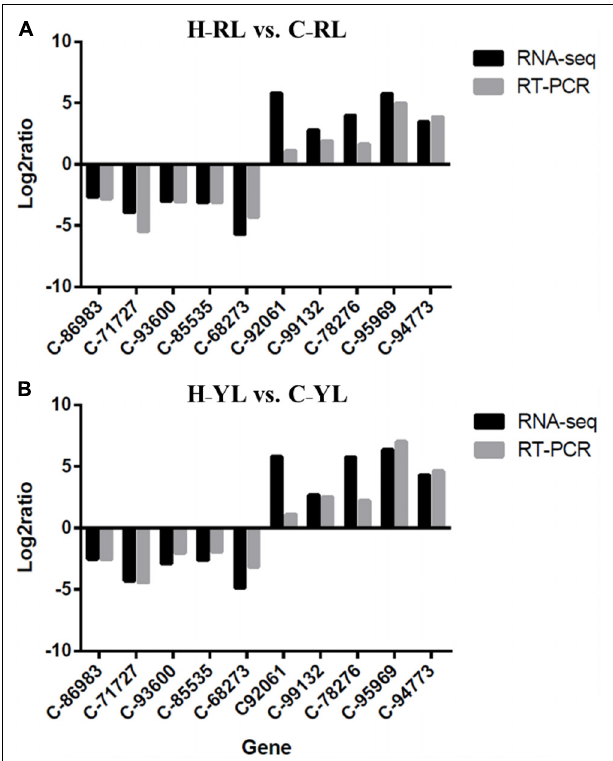
FIGURE 10 | Comparison of qRT-PCR and RNA-seq results. (A) H_RL vs. C_RL; (B) H_YL vs. C_YL.